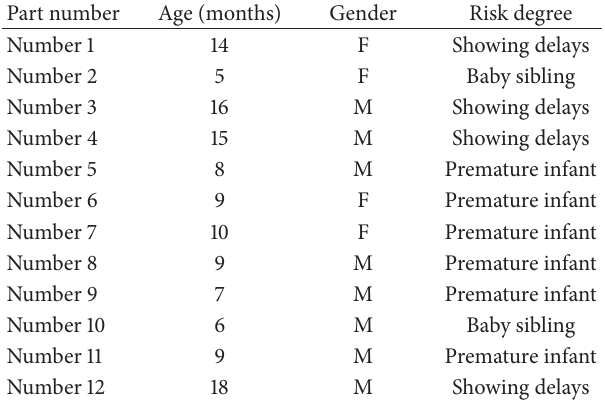
Table 1: Information on participants involved in this study. Each participant was chosen for a different reason: being a baby sibling of someone with ASD, a premature infant, or showing developmental delays. Part